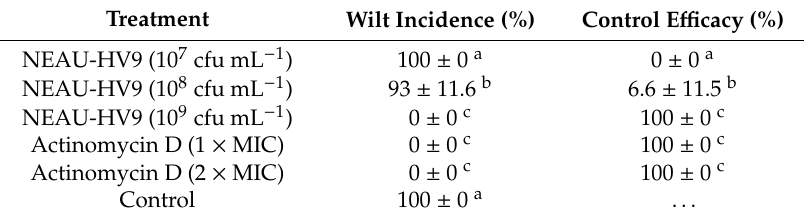
Actinomycin D was highly e ff ective against R. solanacearum in tomato seedlings (Figure 4 and